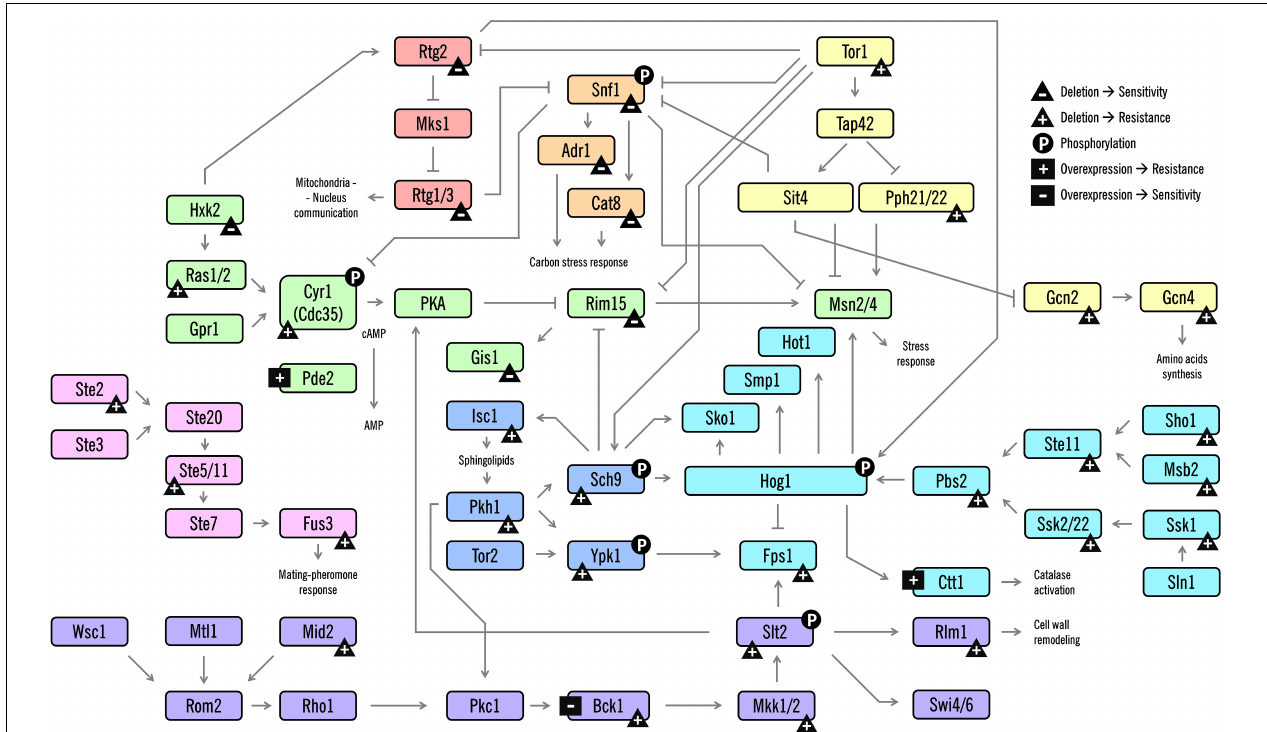
FIGURE 2 | Schematic diagram of the signaling pathways involved in AA-RCD in yeast. Arrows indicate activation of proteins or promotion of a post-translational modification; lines with bars indicate their inhibition/inactivation. Different MAPK signaling pathways or clusters are color-coded as shown. The phenotypes resulting from the deletion or overexpression of the corresponding protein-coding gene are represented with symbols. The symbols are: triangle with a plus (gene deletion confers resistance), triangle with a minus (gene deletion confers sensitivity), square with a plus (protein overexpression confers resistance), and square with a minus (protein overexpression confers sensitivity). Phosphorylation is represented with a circle with a P. Some phenotypes were not included due to contradictory data among the studies. For clarity, despite the number of different proteins and signaling cascades displayed in this scheme, not all players, connections between the pathways and direct targets of the proteins are